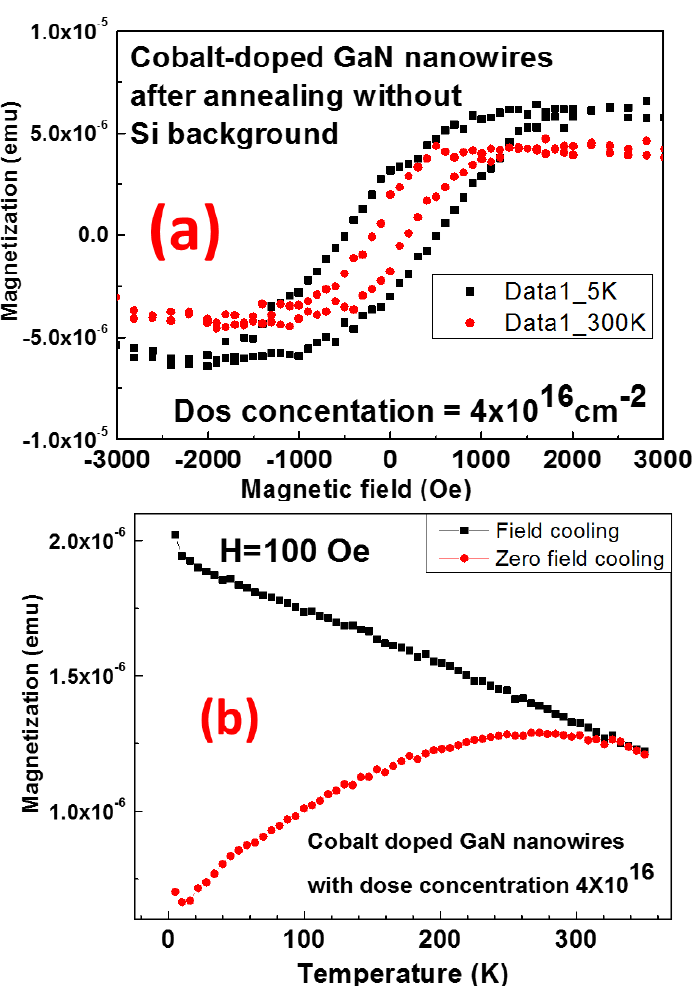
Figure 6. For cobalt-implanted GaN Nanowire with dose concentration of 4 × 10 16 cm − 2 after annealing, ( a ) M–H measurement without Si background at 5 K/300 K and ( b ) M–T measurement at applied field of 100 Oe.